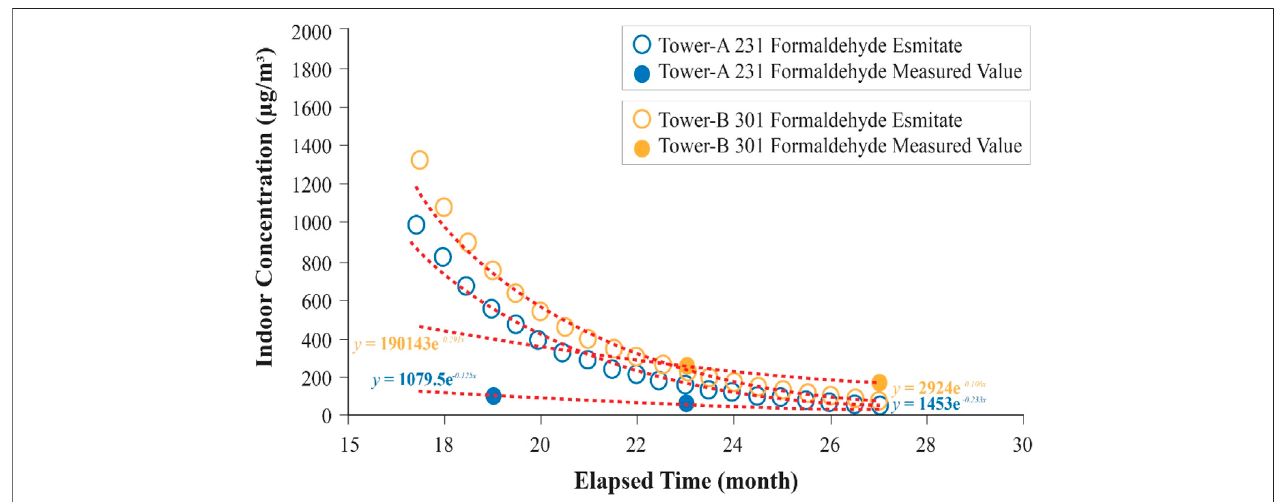
FIGURE 16 | Comparison between formaldehyde estimate and measured value at Tower-A231 and Tower-B 301.